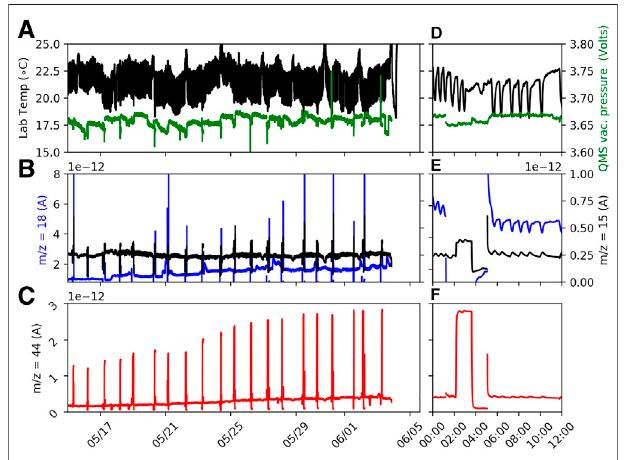
FIGURE5| Thesixenvironmental correlatesthatweremeasured bythe SWIMS instrument or CTD to capture variations in the environment that are likely to in fl uence the signal response (s) of the SWIMS for m/z (cid:3) 32 and other dissolvedgases.Panel (A) showsinstrumentwaterdepthashydrostatic pressure and the ion current for water vapor (mass 18). Panel (B) shows the temperature of the electronics (uC temp) and the water temperature. Panel (C) shows the sample temperature or temperature of the heater block where gas is introduced across the membrane, and it shows ion current at mass 5, the electronic noise